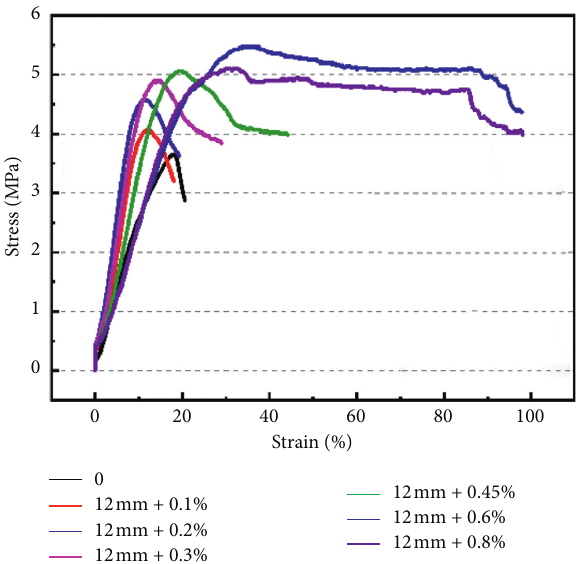
Figure 9: Stress-strain curve for the UCS test on fiber-reinforced